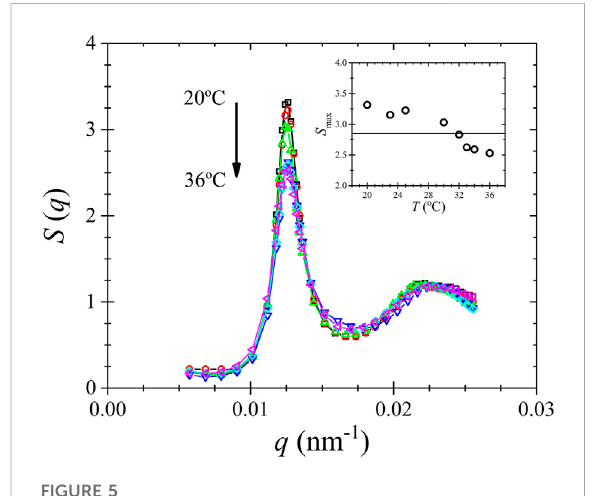
FIGURE 5 Measured static structure factor measured right after quenching atdifferent temperatures for system KPS0.6. The arrow indicates the interval temperature under study, and its direction pointstohighertemperatures.Inset:Heightofthemeanpeak of the structure factor, S max , as a function of temperature. The horizontal line indicates the Hansen-Verlet criterion, corresponding to S ( q ) = 2.85.